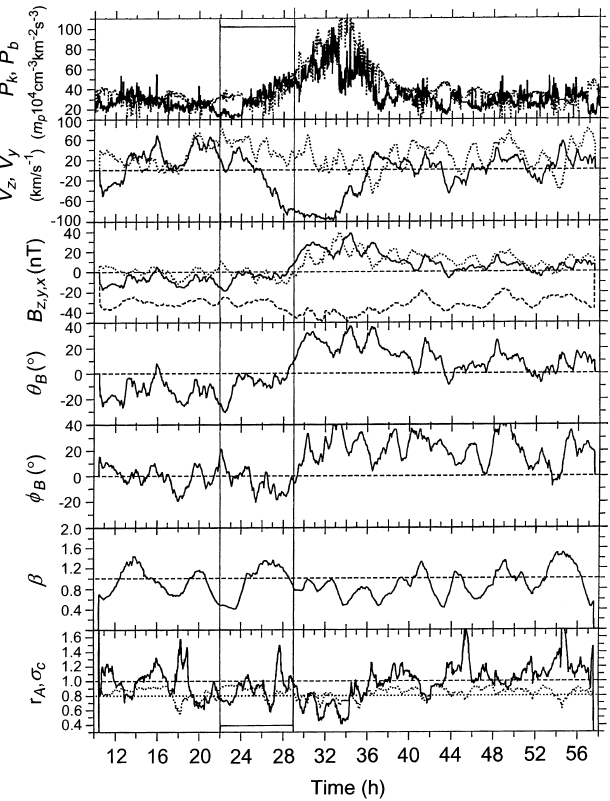
Fig. 2. Time-sequences of various parameters with different time resolutions for the same period as in Fig. 1. The first panel shows the high-time-resolution data of the total thermal pressure with the assumption of T e (cid:136) T p in units of m p 10 4 cm ) 3 km 2 Æ s ) 2 ) and the magnetic pressure indicated by the dotted curve . The original data were averaged over 81 s. From the second to the fifth panel we show data obtained by averaging the original time-series over a 1-h-period window shifted continually by 81 s. The parameters are: the z ( solid line ) and y ( dotted line ) component of the flow velocity; the z ( solid line ), y ( dotted line ) and the radial x ( dashed line ) component of the magnetic-field vector; the elevation angle (in degrees) of the magnetic- field vector with respect to the equatorial plane; the azimuthal angle of the magnetic-field vector; the plasma beta, i.e. the ratio between the thermal pressure and magnetic pressure; and finally in the last panel the Alfve´n ratio ( solid line ), the ratio between the kinetic fluctuation energy and the magnetic fluctuation energy, and the normalized cross- helicity according to Roberts et al . (1987) given by the dotted line and calculated for a 1-h period continually shifted by